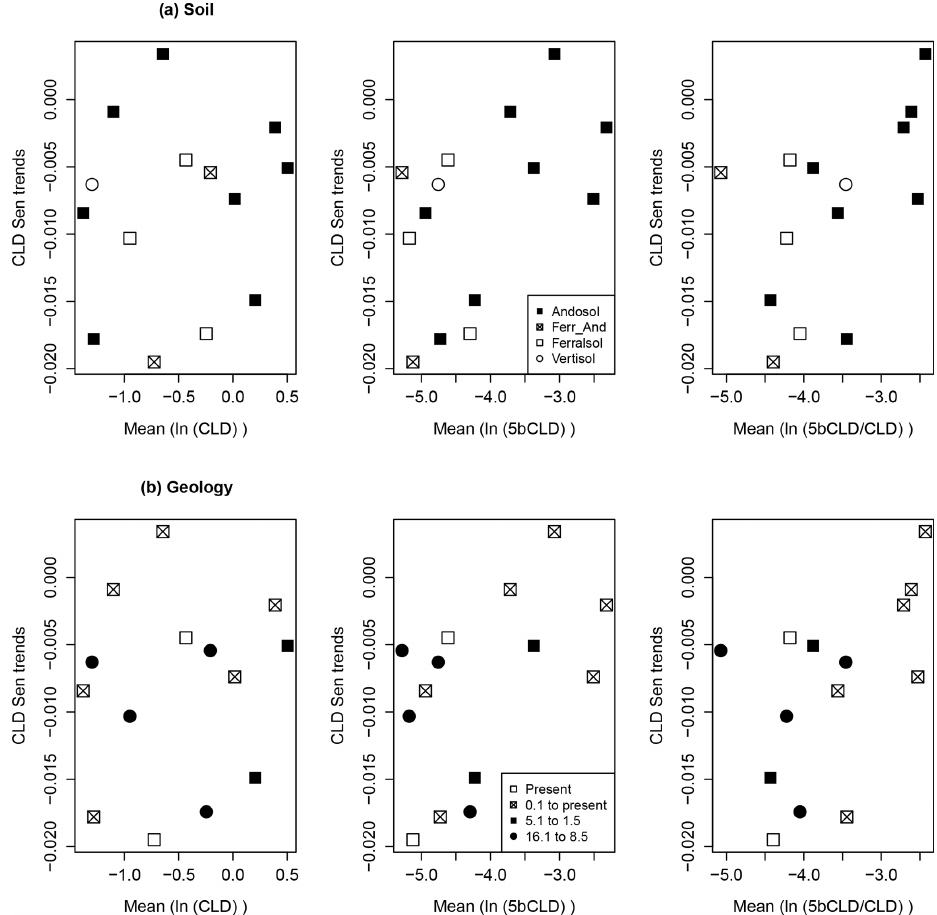
Figure 7. Sen trends of CLD vs. mean log content of CLD, 5bCLD and 5bCLD / CLD ratio (from left to right – natural logarithm) in SW, according to (a) soil and (b) geology (for soil and geology, see legend in the middle figure).